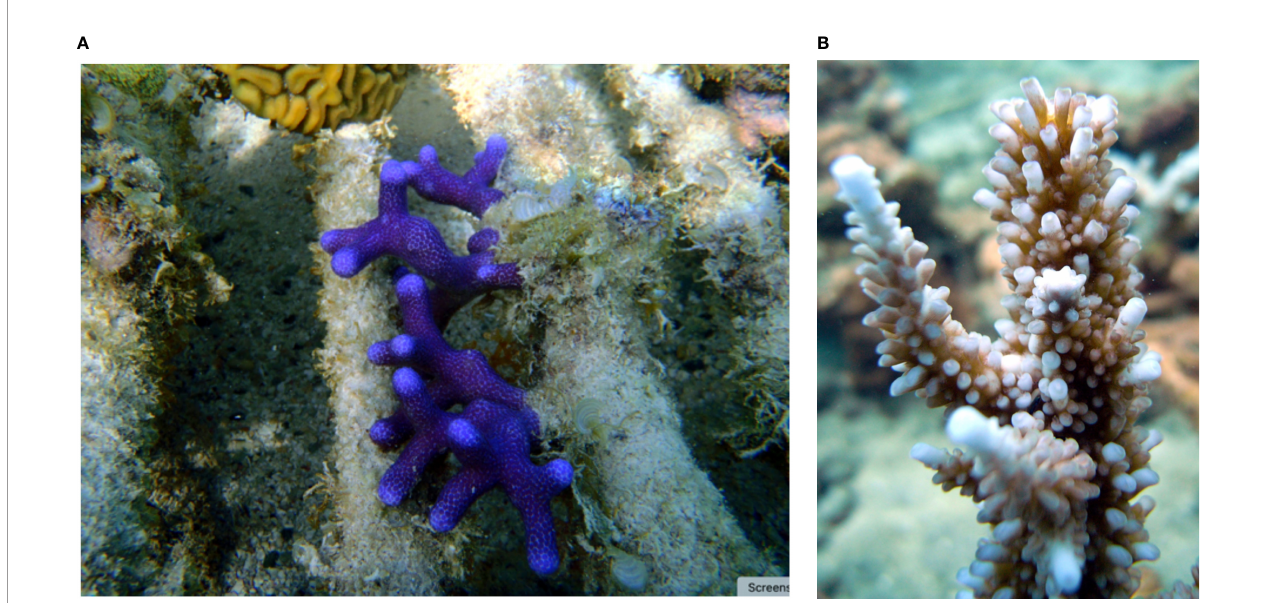
FIGURE 10 | (A) The intense glowing purple color of these Biorock corals fades when power is off for a few days and darkens in hours when power is restored. Antigua, photograph by Martha Watkins Gilkes. (B) Biorock corals have more densely packed and more brightly colored polyp tips than controls. Pemuteran, Bali. Closeup photograph by Wolf Hilbertz.